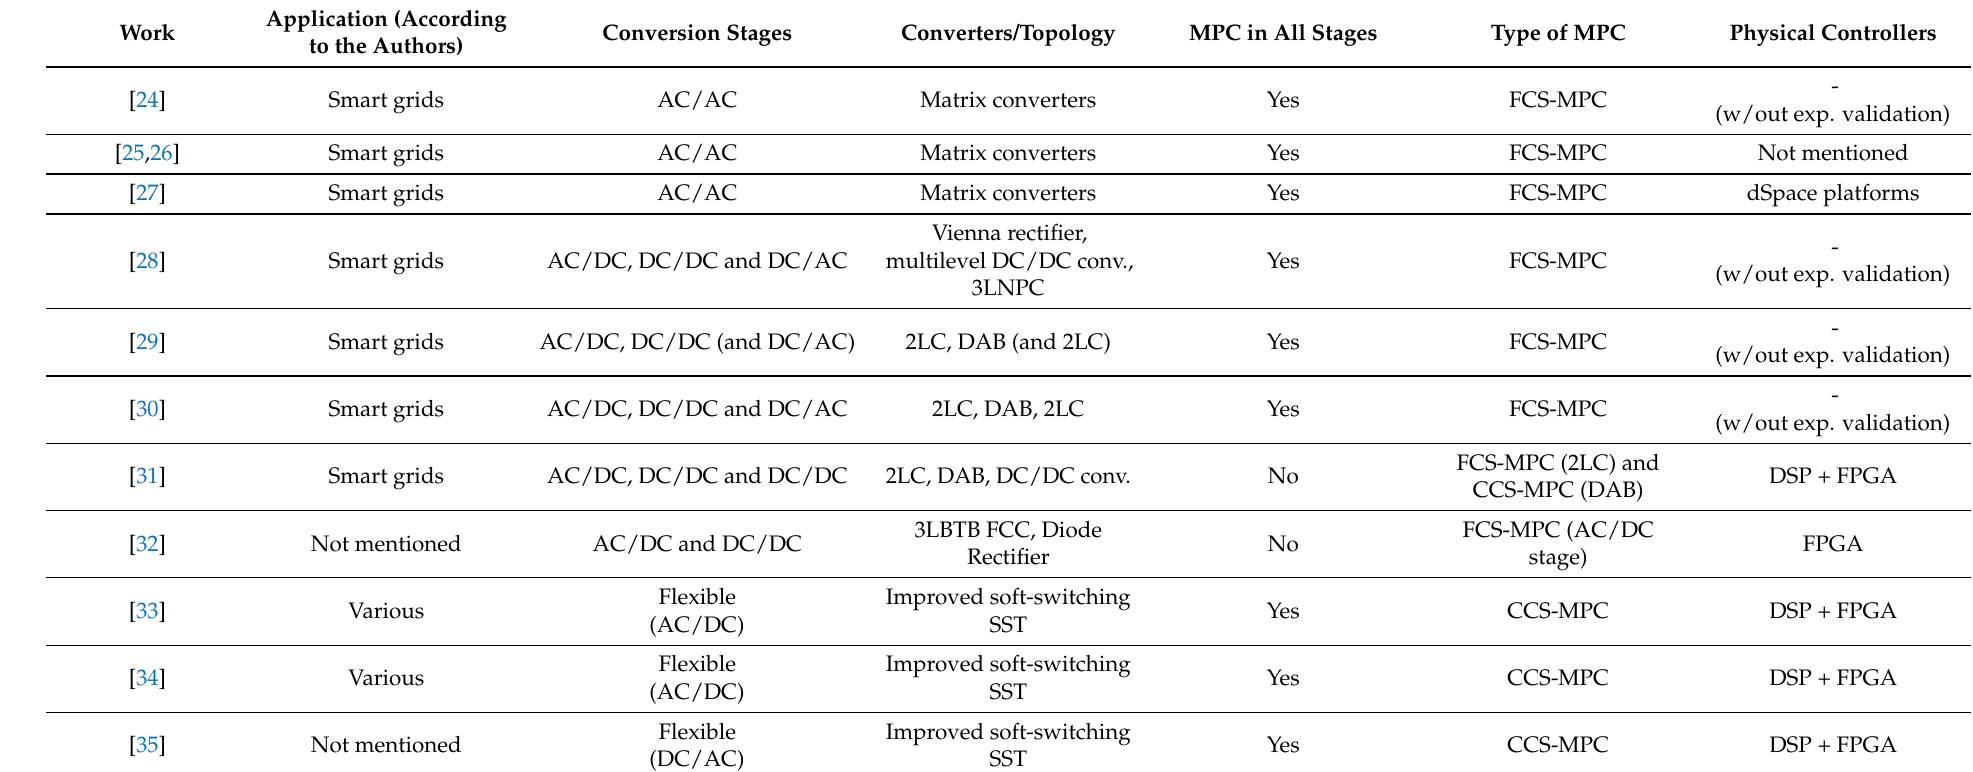
Table 1. MPC strategies in non-modular SST